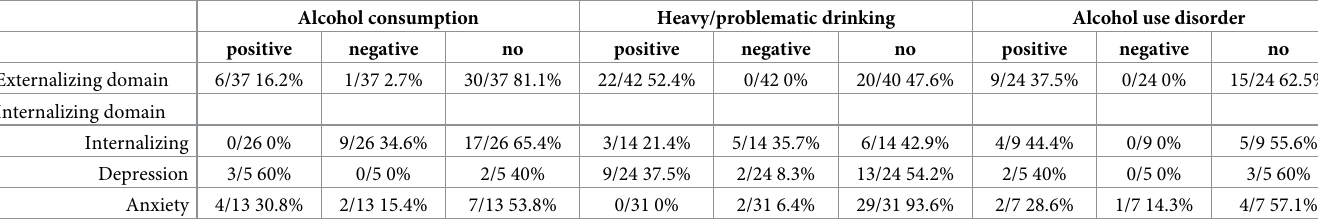
Table 2. Distribution of associations across subtypes of mental health problems and alcohol use